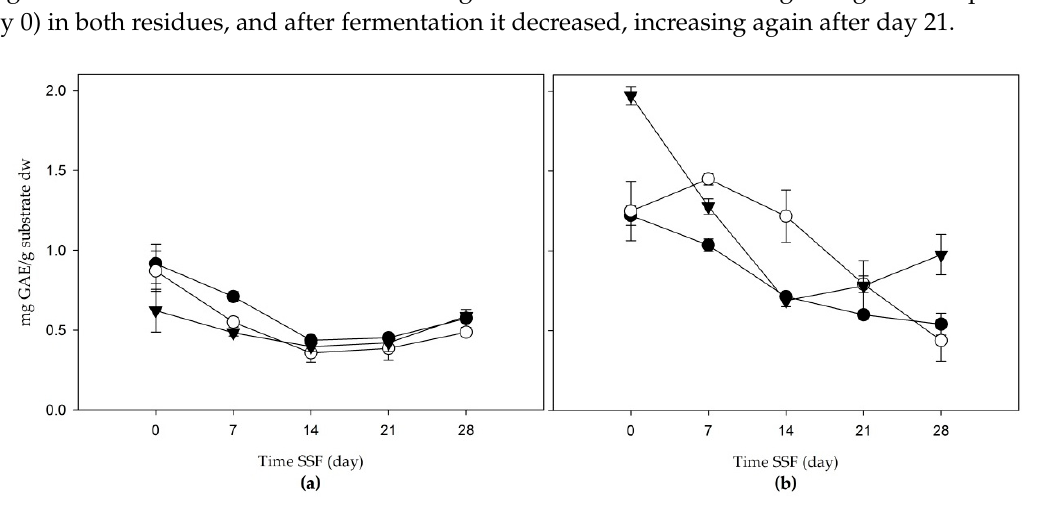
Table 1. Physicochemical characteristics of apple bagasse and agave mezcalero bagasse. Agroindustrial Residue